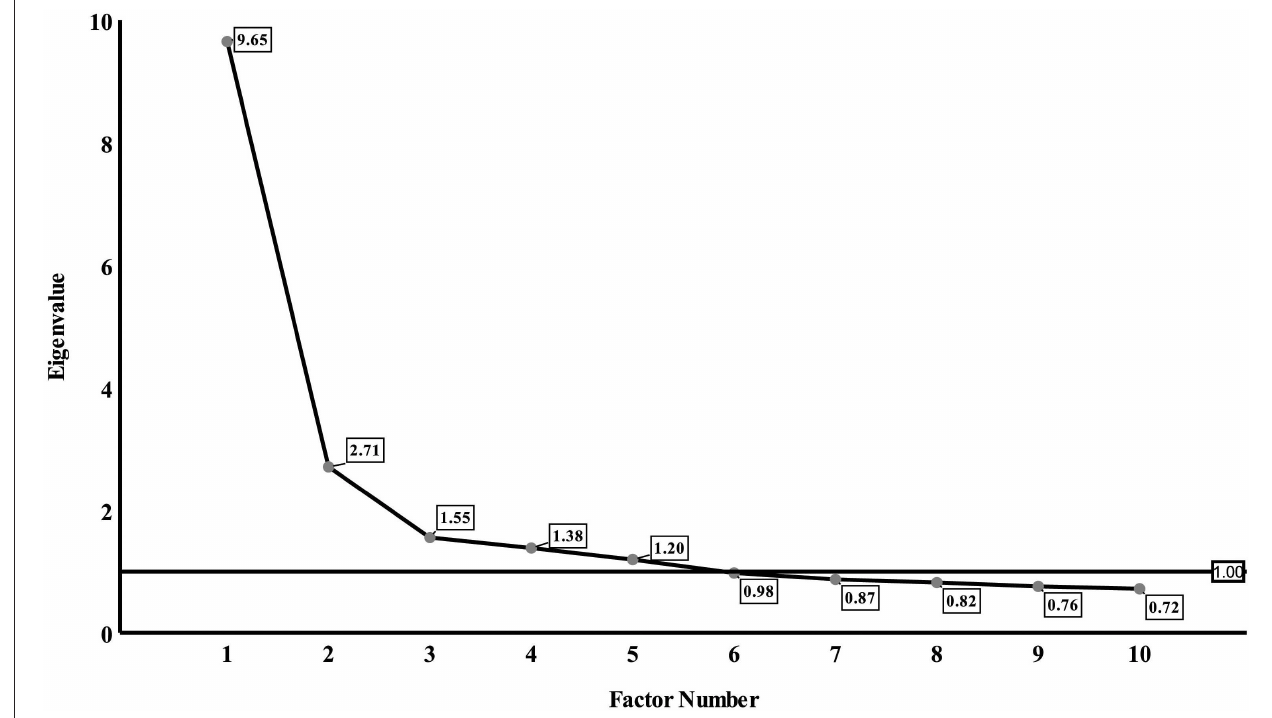
a solution that is more concise and easier to interpret than the initial factor extraction (17). Individual acylcarnitines that had the maximum loading for a factor were used as relevant components of the factor. Scree plot is a line plot of the eigenvalues of factors in factor analysis (18). The horizontal axis of the scree plot is the number of factors, and the vertical axis is the eigenvalue of factors. The number of acylcarnitine factors was determined by eigenvalue, communalities, and scree plot: eigenvalue > 1, communalities ≥ 50%, number of factors located on the steep slope of the scree